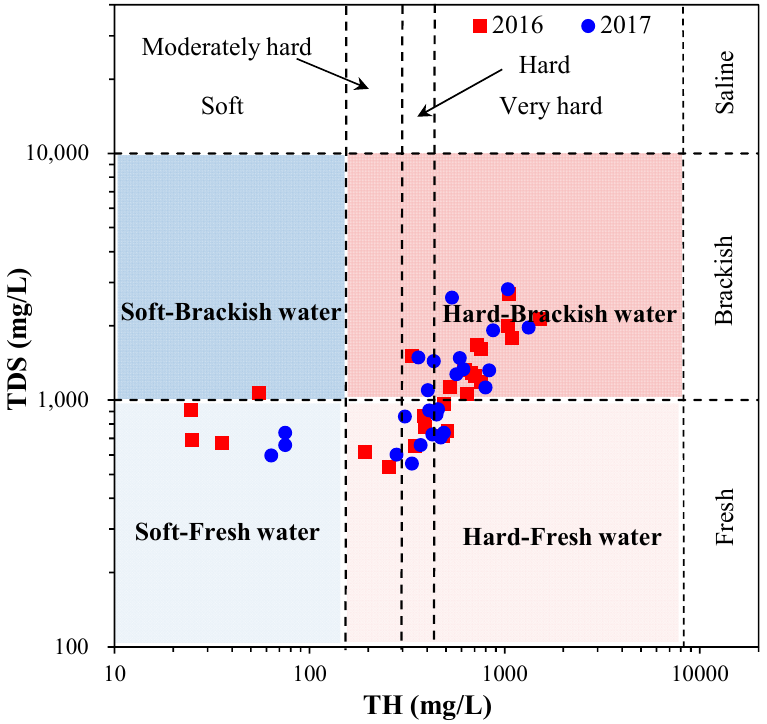
Figure 2. Plot of total dissolved solids (TDS) versus total hardness (TH) of groundwater.